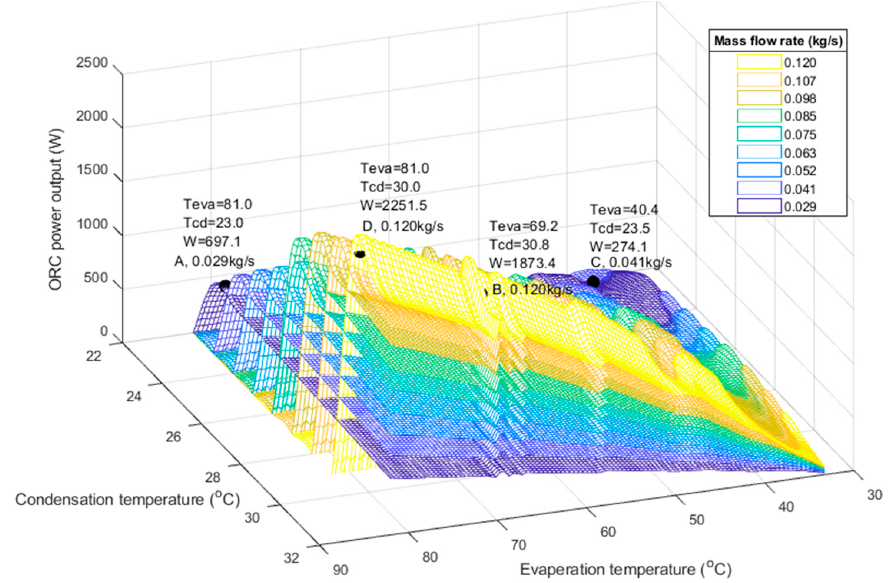
Figure 8. ORC power output map within 4D boundary conditions.